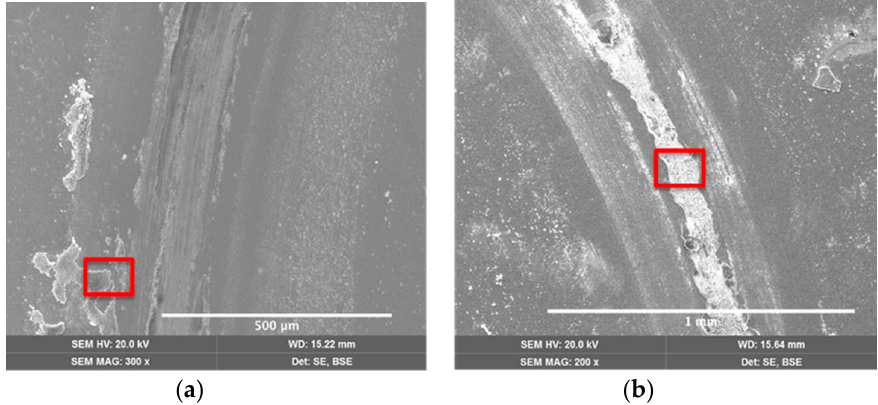
Figure 10. SEM images of wear tracks of coatings deposited in a reactive atmosphere: ( a ) ArN0Ag sample; ( b ) ArN4Ag sample.